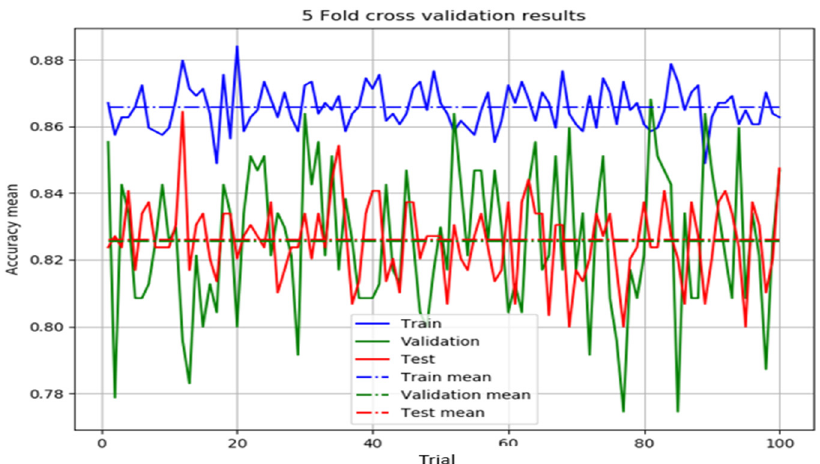
Figure 1. The average percentage of correctly classified patterns for 100 algorithms during k -fold cross-validation ( k = 5) tests.